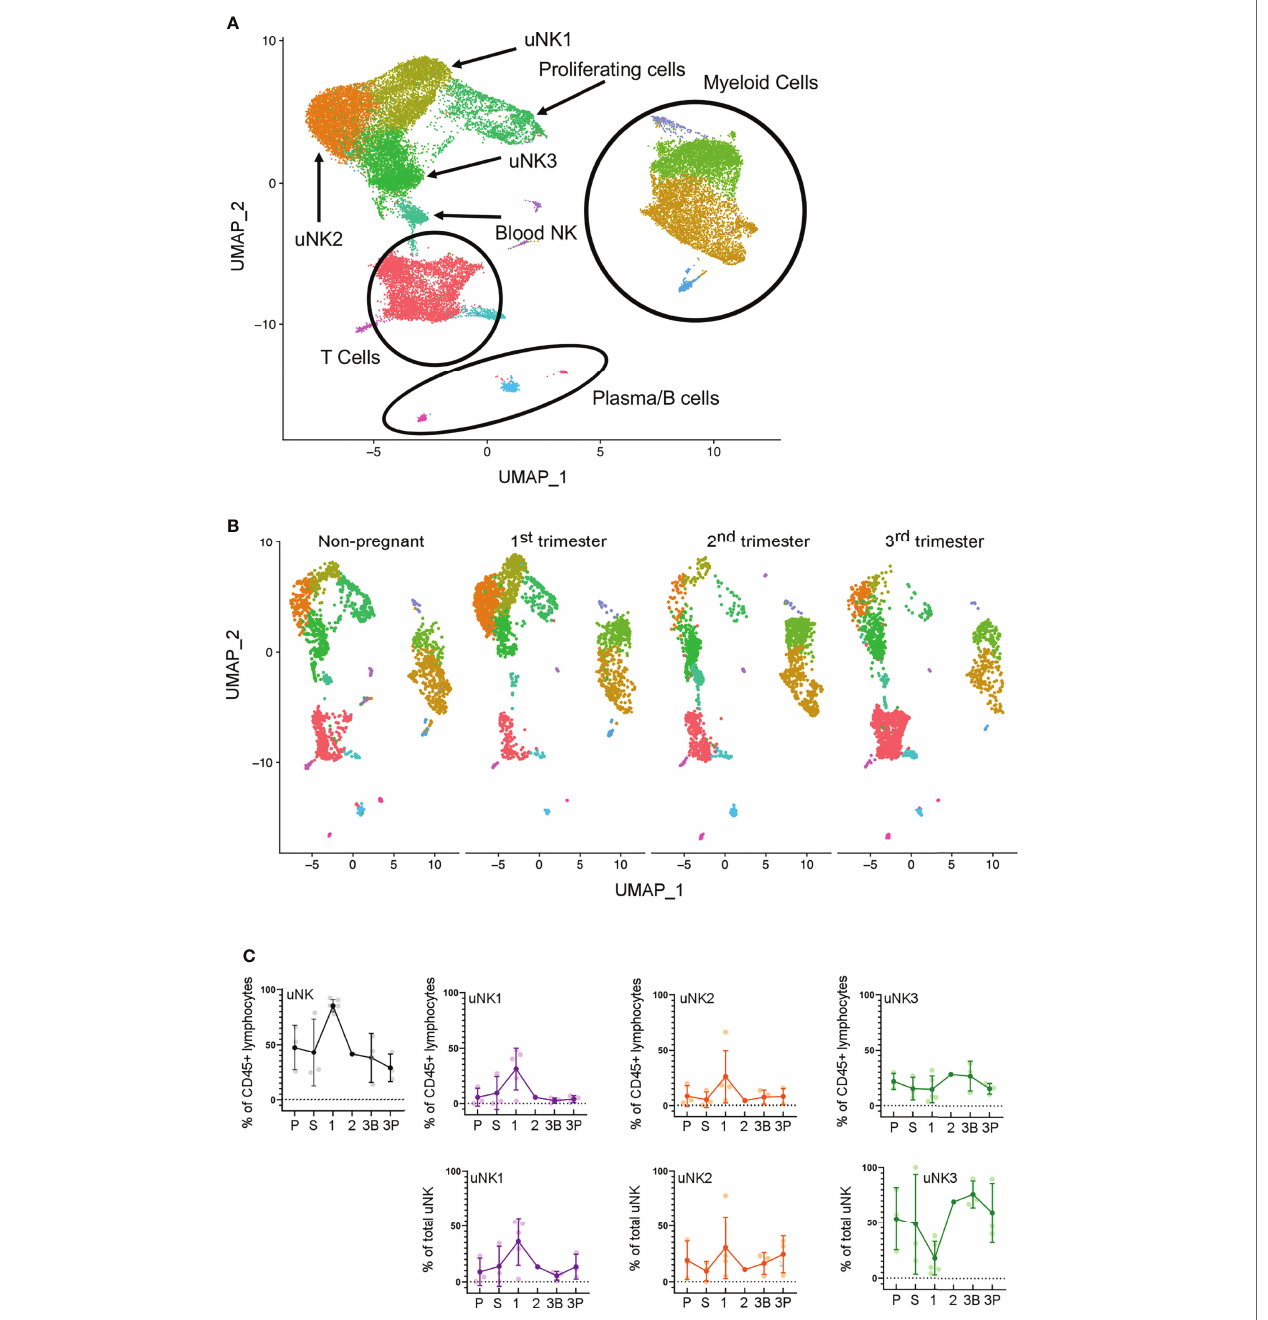
FIGURE 1 | uNK1, uNK2, and uNK3 are present throughout the human reproductive cycle, by scRNAseq. (A) Integrated immune cells from non-pregnant endometrium, and fi rst-, second-, and third-trimester decidua, visualised by Uniform Manifold Approximation and Projection (UMAP). Colours are indicative of clusters and are identi fi ed with appropriate immune cell types. n = 12 (non-pregnant), n = 5 (1T), n = 1 (2T), n = 3 (3T). uNK, uterine natural killer. (B) Immune cells from each of the four stages in the reproductive cycle subset to 2,200 cells. Immune cells separated by stage and then visualised by UMAP. Colours are indicative of clusters. (C) Using the scRNAseq dataset, graphs show frequency of total NK from CD45+ lymphocytes and then frequency of each uNK subset (uNK1, uNK2, and uNK3) as both a proportion of CD45+ lymphocytes and a proportion of total uNK cells. Means and SDs are shown for n = 3 (proliferative), n = 3 (secretory) n = 5 ( fi rst trimester), n = 1 (second trimester), n = 3 (third-trimester decidua basalis), and n = 3 (third-trimester decidua parietalis). P, proliferative phase; S, secretory phase; 1, fi rst trimester; 2, second trimester; 3B, third-trimester decidua basalis; 3P, third-trimester decidua